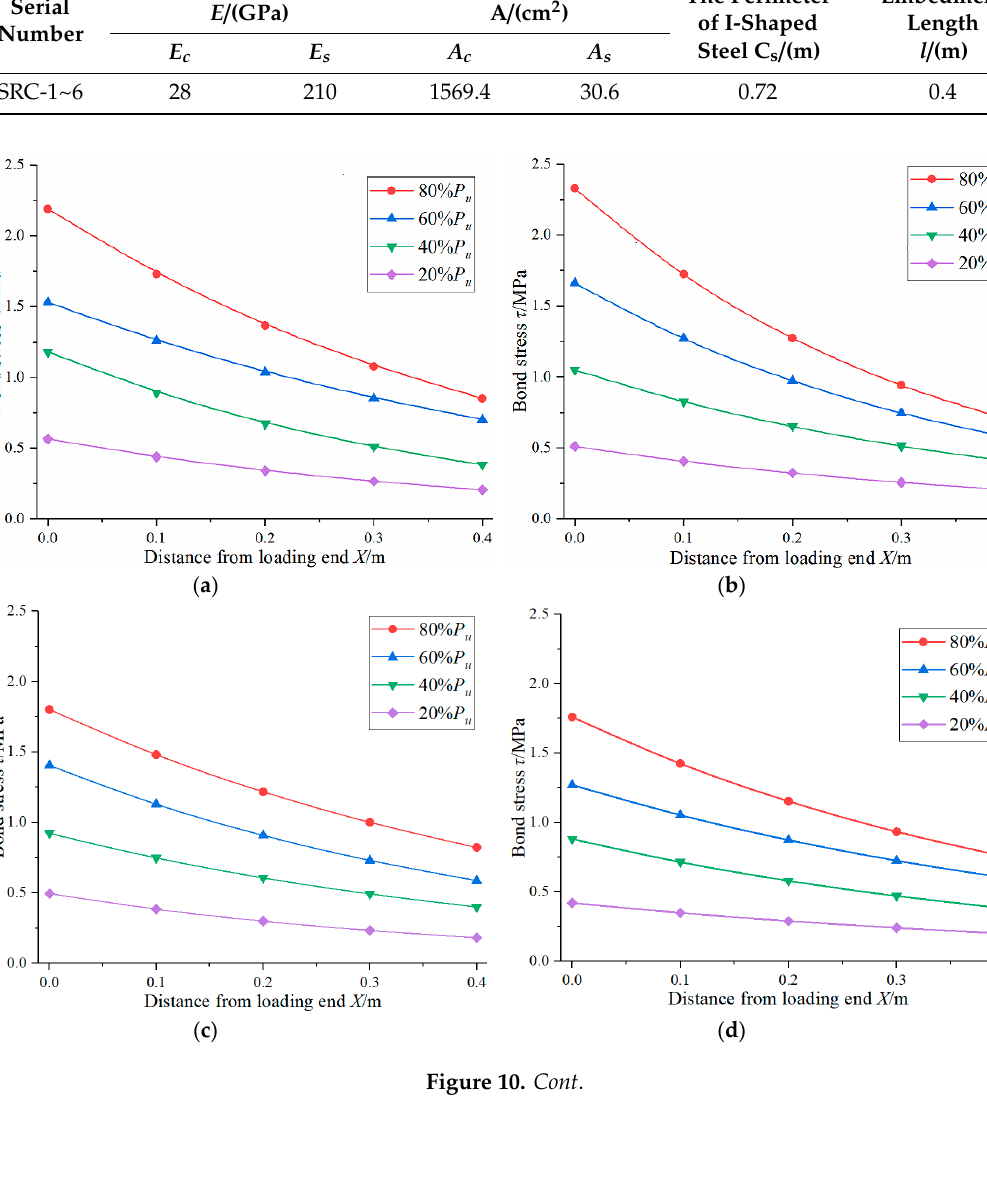
Table 4. Characteristics of push-out specimens.